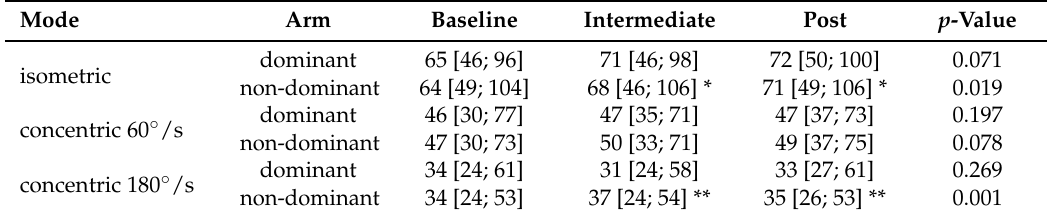
Table 2. Peak elbow flexion [Nm] reached during isokinetic dynamometer measurements.